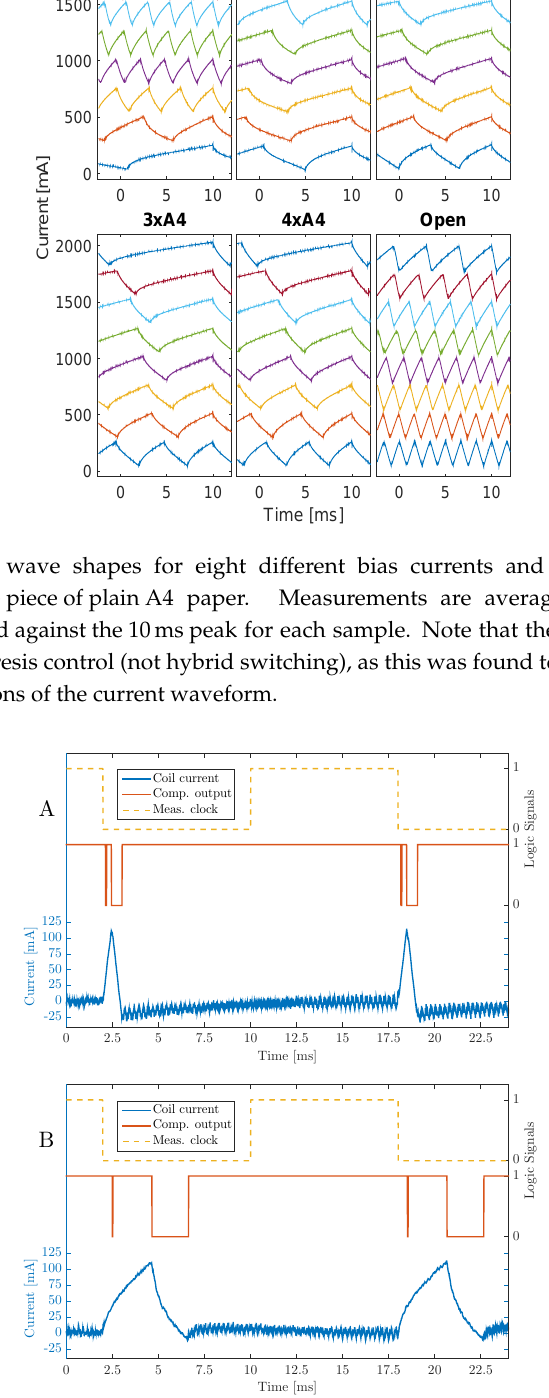
Figure 13. Comparison between nominal current waveforms using hybrid switching for: ( A ) an open circuit, having a large air-gap; and ( B ) a closed circuit, having no air-gap. Nominal switching frequency was 16kHz, and sampling was done at 62Hz. Measurements were initiated on every falling edge of Meas. clock. In each each measurement cycle, the difference in time between the two first falling edges of the Comp. output defined the measured